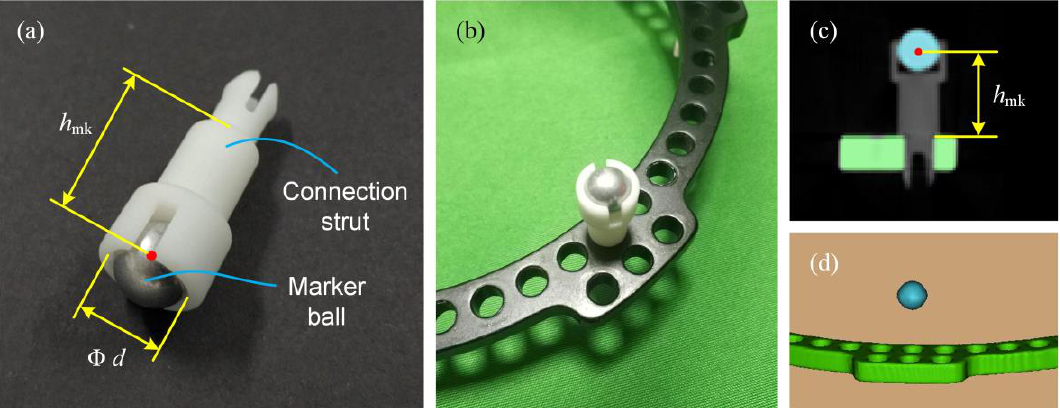
Figure 2. ( a ) Structure of the image marker. ( b ) Image marker installed on a fixation ring. ( c ) CT image region segmentation. ( d ) 3D reconstruction result.